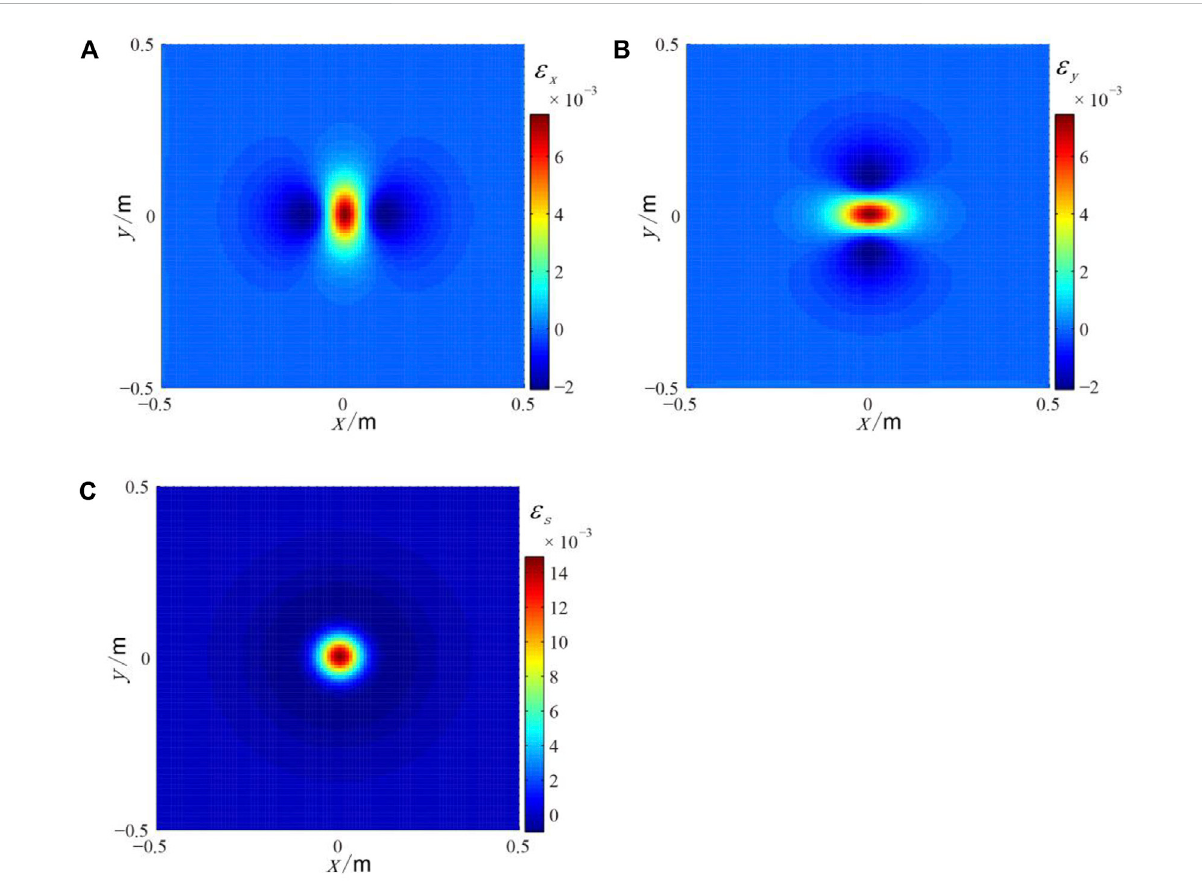
FIGURE 2 The strain fi eld distribution around the punctate load model of horizontal slices at depth of 0.1 m (A) The linear strain ε x ; (B) The linear strain ε y ; (C) The area strain ε s .